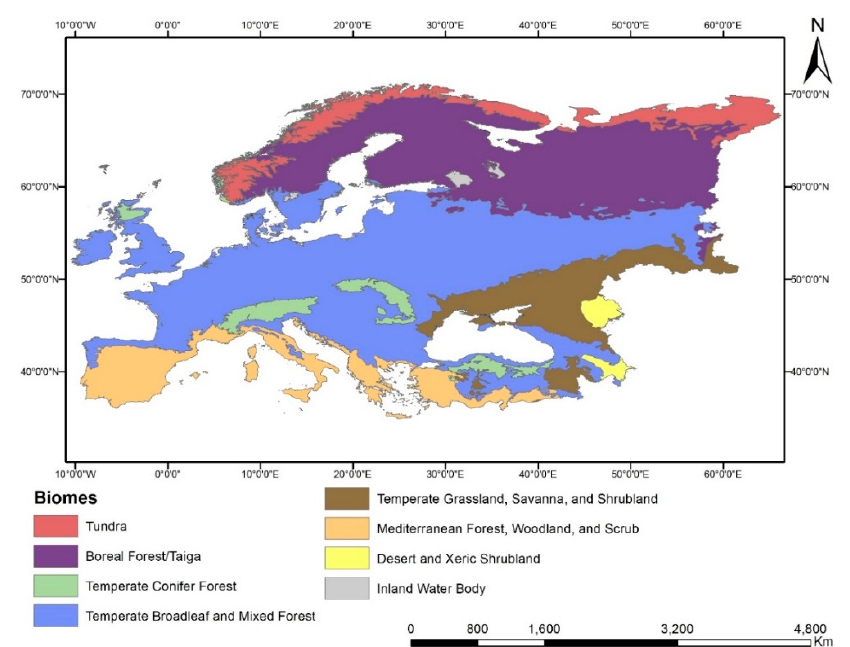
Figure 1. European biomes within the study area based on the World Wide Fund for Nature (WWF)–Terrestrial Ecoregions of the World website (https://www.worldwildlife.org/publications/terrestrial- ecoregions-of-the-world).